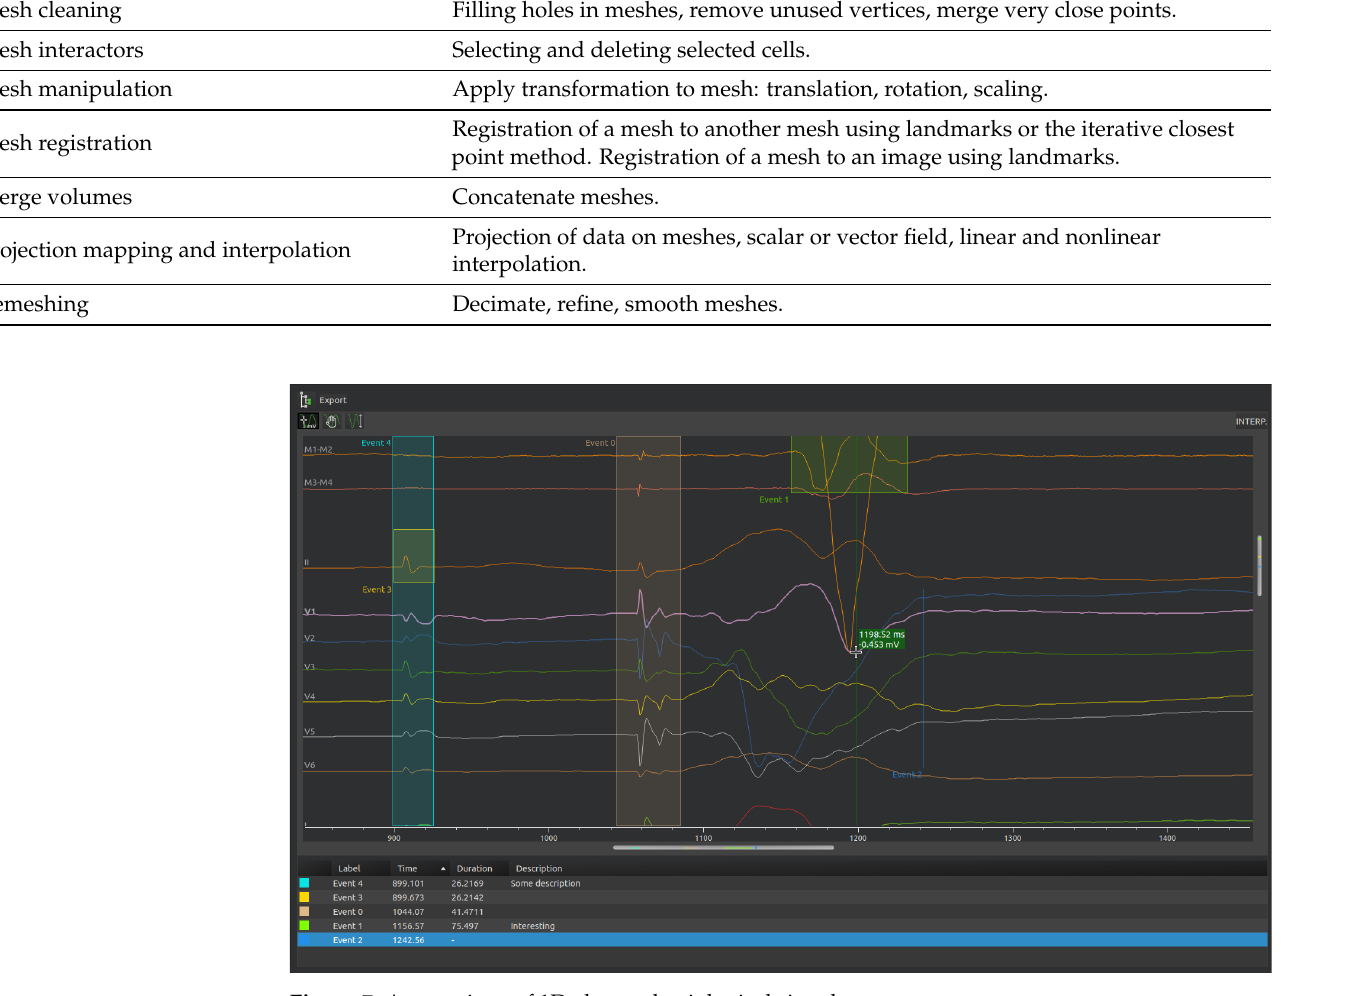
Figure 7. Annotations of 1D electrophysiological